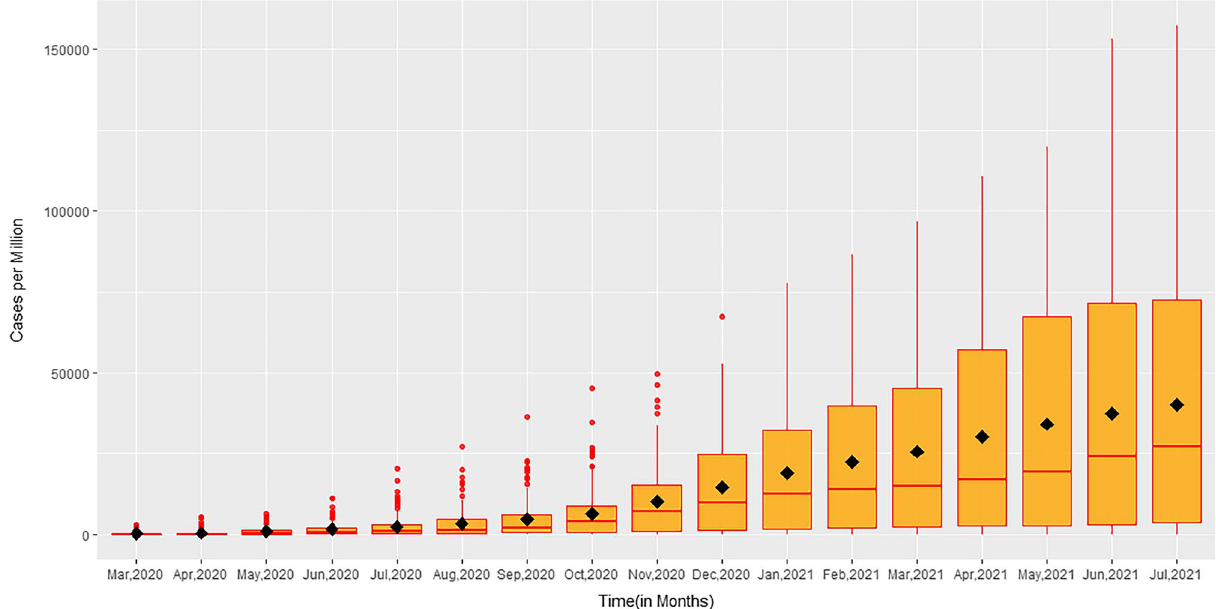
Figure 2. Box plot for total cases per million from March, 2020 to July,